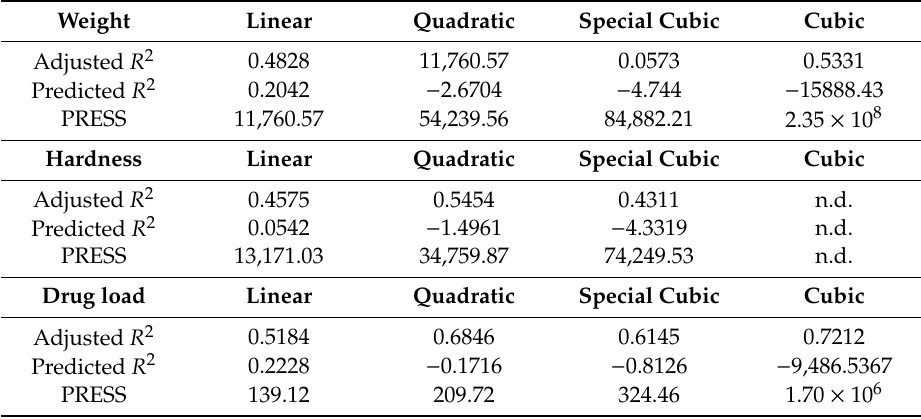
Table 4. Model summary